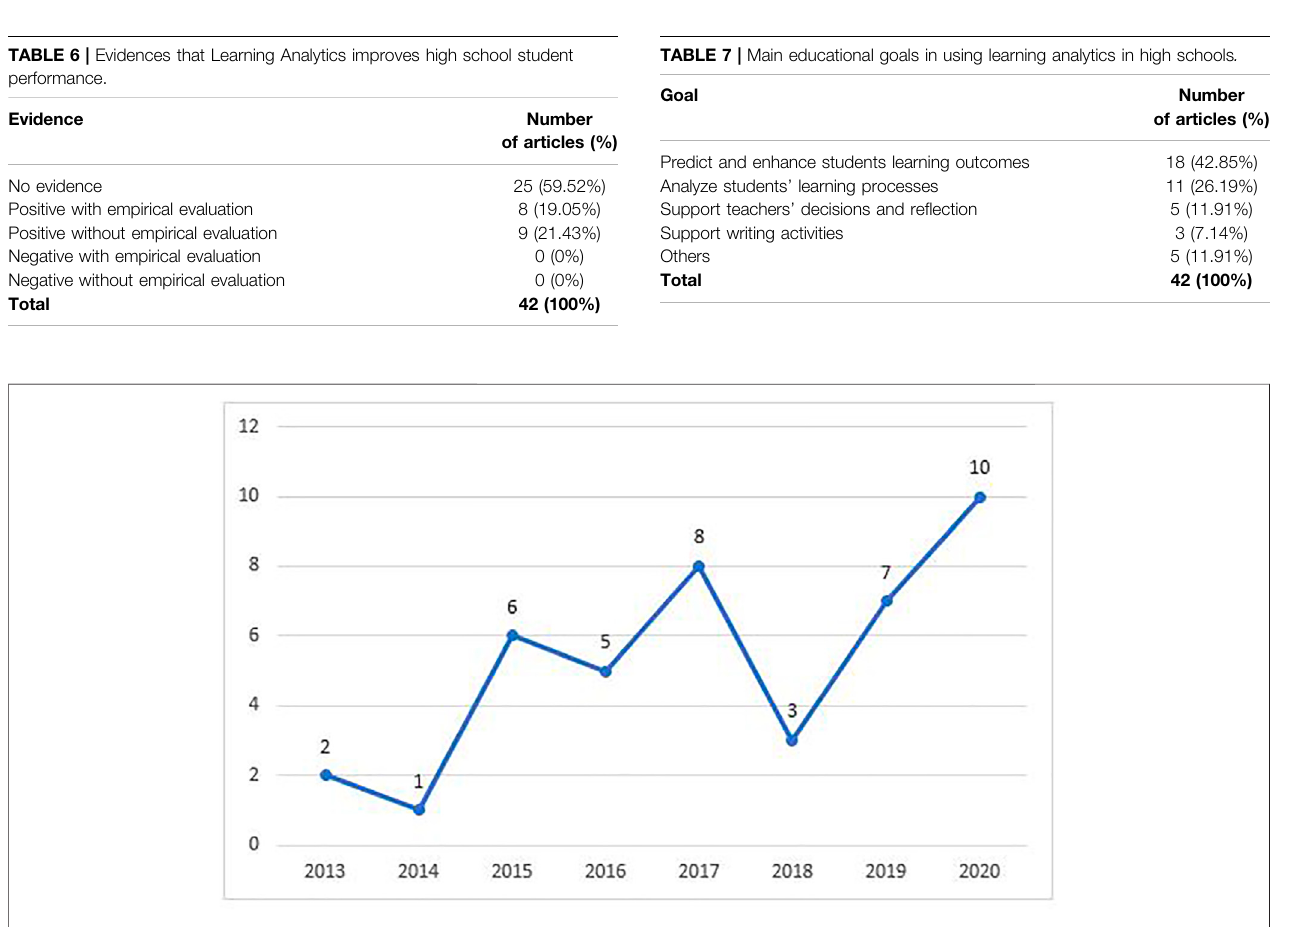
FIGURE 2 | Distribution of the papers included in the review across years.